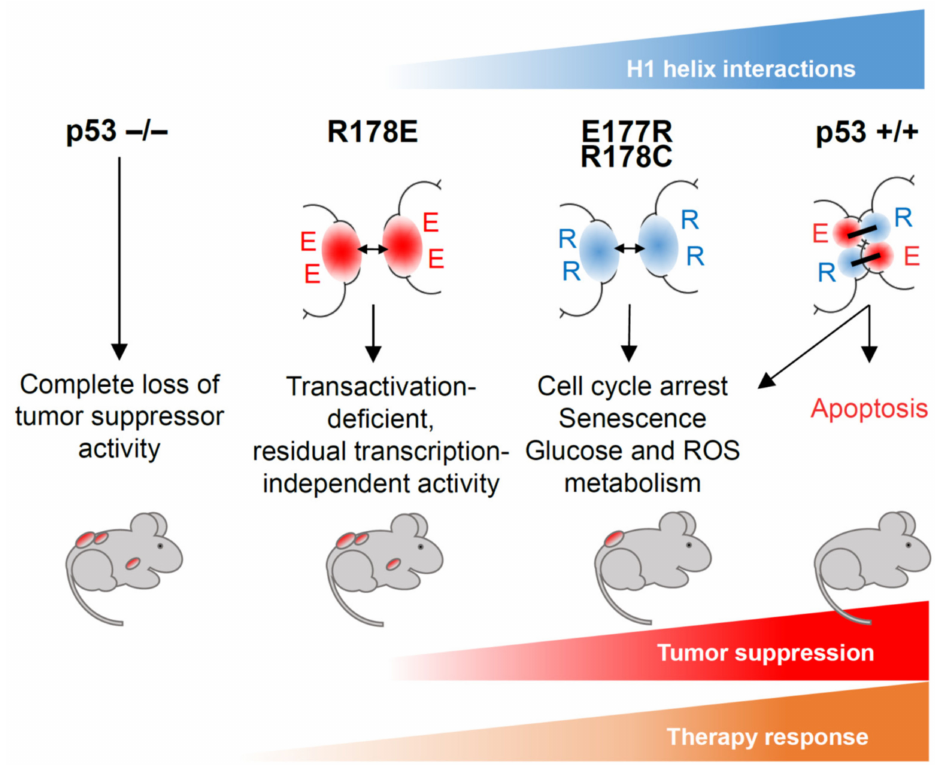
Figure 4. Cooperativity mutant mouse models show that the strength of interaction between H1 helices determines the functional activity of p53. Loss of cooperativity in p53R178E (p53EE) mouse leads to a phenotype similar to p53 knock-out, but residual transcription-independent activity provides a better therapy response in comparison to p53-null. Reduced cooperativity (E177R, R178C) results in compromised apoptosis but retained pro-survival functions of